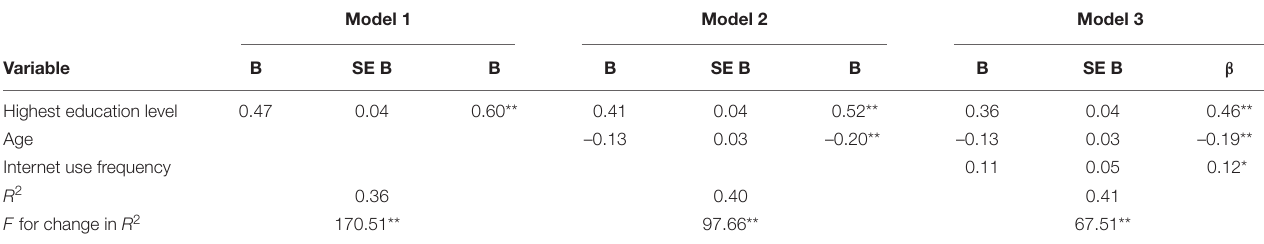
TABLE 5 | Summary of stepwise regression analysis for variables predicting trust ( N =